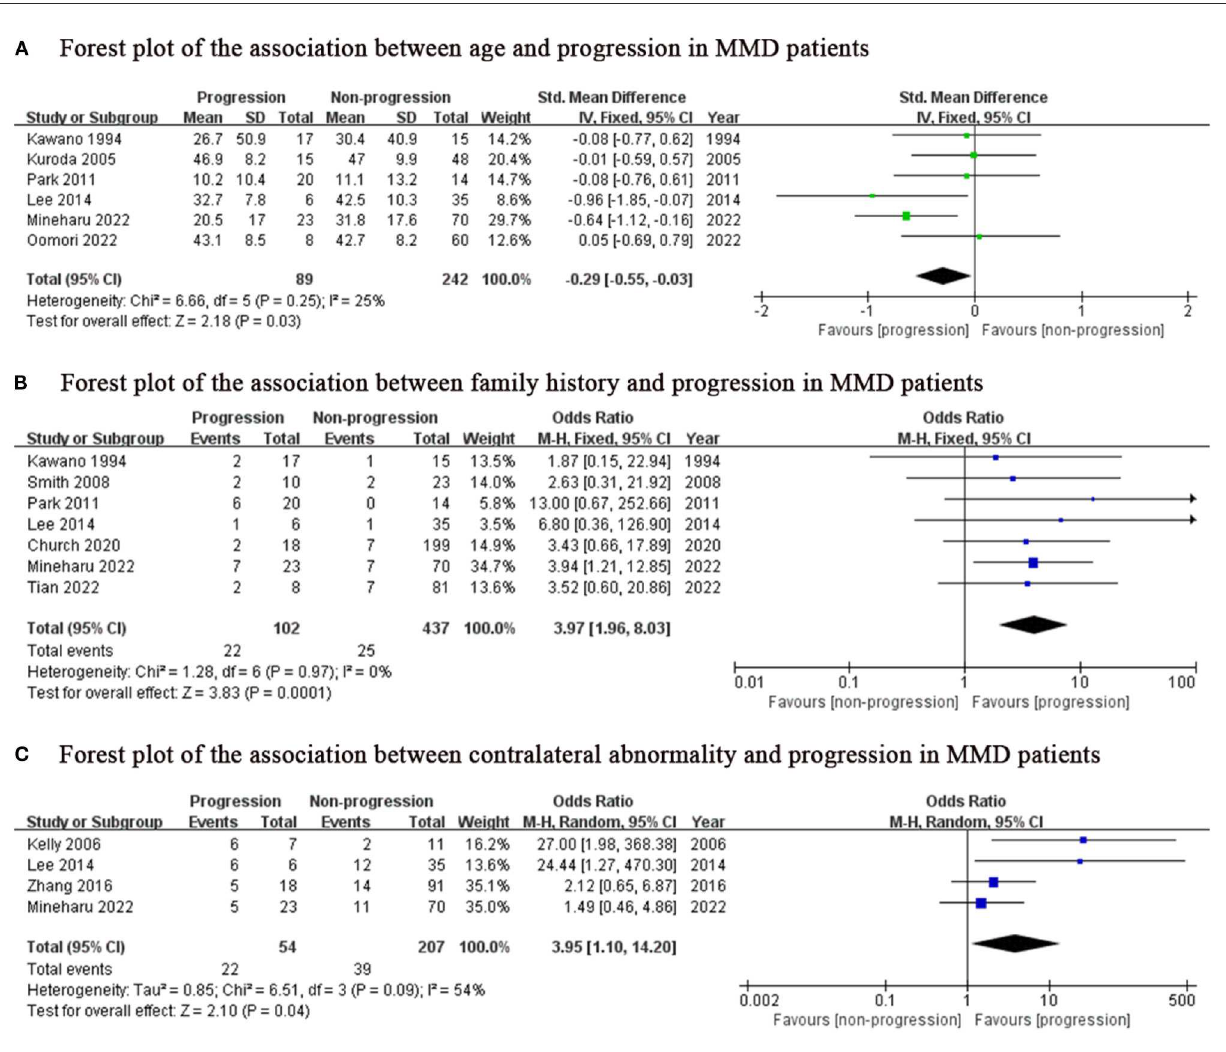
FIGURE2 Positive predictor for progression in MMD patients. MMD, moyamoya disease; SD, standard deviation; IV, Inverse variance; M-H, Mantel-Haenszel; df, degrees of freedom; CI, Confidence Interval; Std. Mean Difference, standardized mean